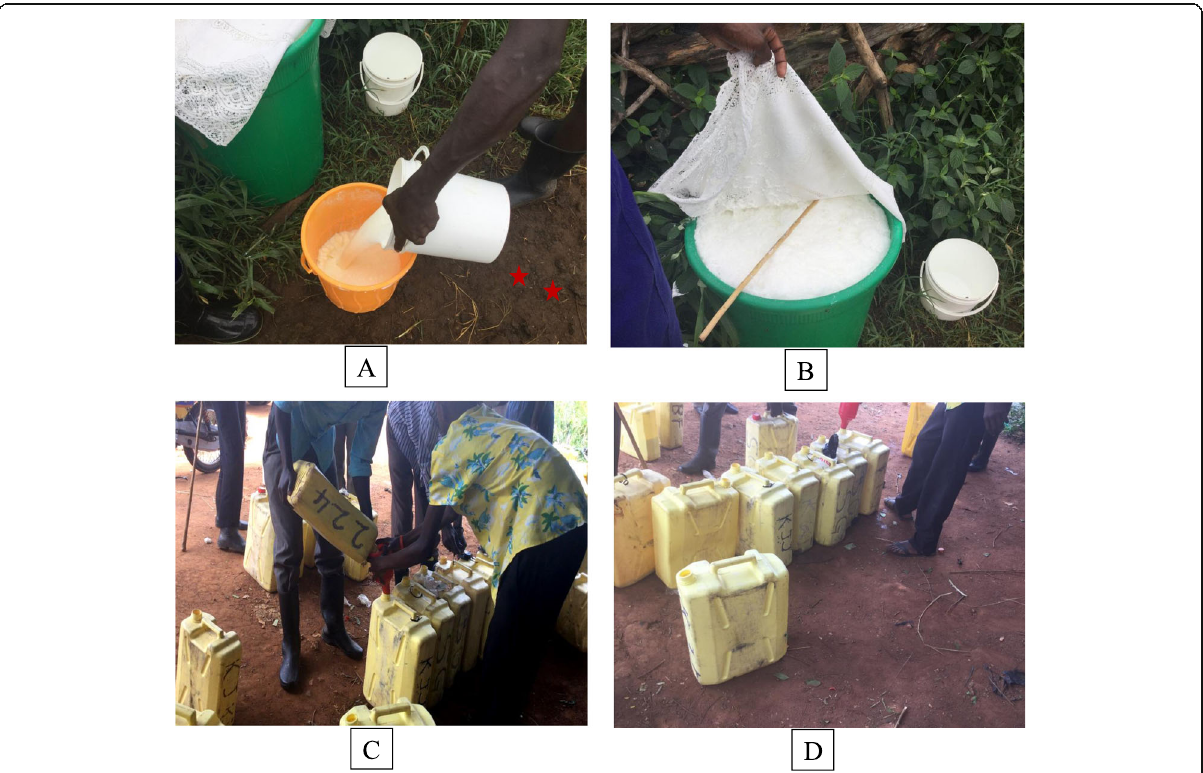
Fig. 3 Milk handling practices in Nakasongola district. a Milk is dispensed in a plastic container. In the background is a green bucket for keeping large volume of milk. Also note the presence of dry cow dung marked by red stars. b Milk is protected with a cloth/towel from flies and dust. c A typical roadside mobile milk-collecting centre. Milk is dispensed from plastic cans by mobile milk vendors to other cans at the centre. d A mobile milk-collecting centre showing the poor hygiene. The environment is dusty or muddy and littered with garbage